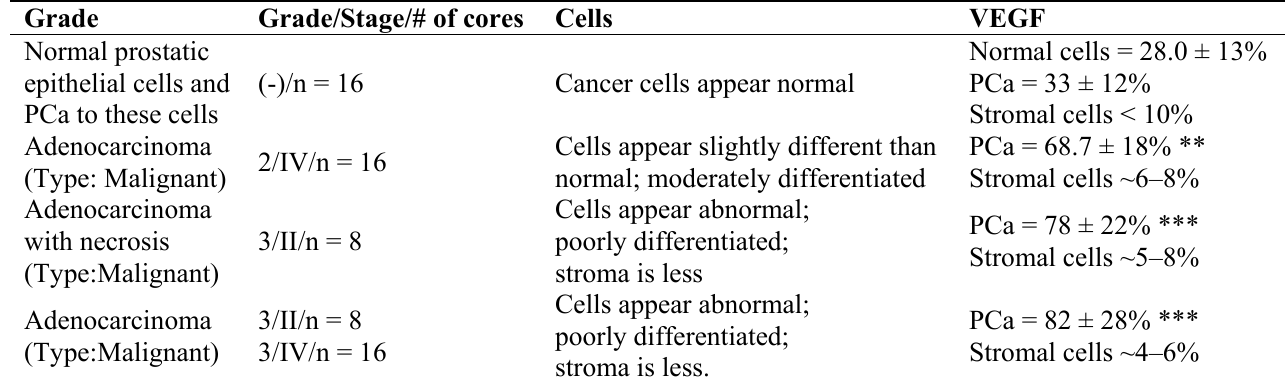
Table 1. Expression of VEGF in prostatic carcinoma and cancer adjacent to normal prostate tissue sections. Prostatic carcinoma and normal tissue microarray containing 12 cases/24 cores was used. Immunohistochemistry was performed with an antibody